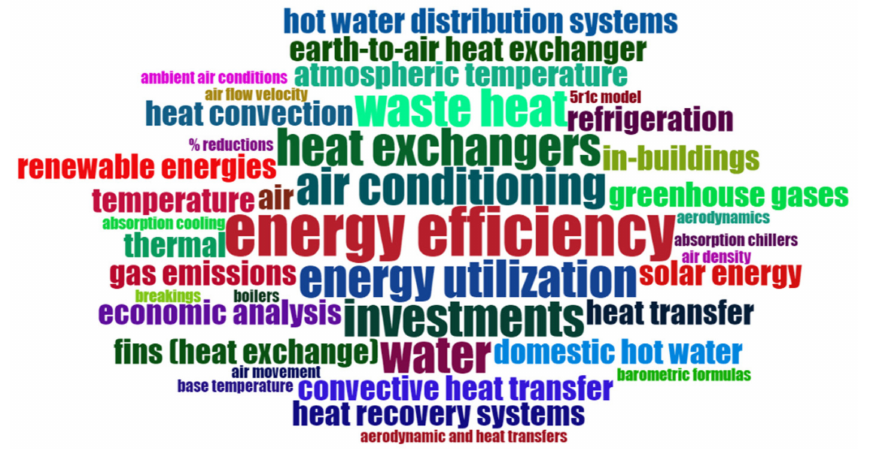
Figure 1. A word-cloud created from the articles published in the Special Issue. Zhao et al. aimed to optimize the flow and heat transfer performance of channels with frustums of a cone by using Response Surface Methodology (RSM) and multi-objective genetic algorithm [2]. Central composite face-centered design (CCF) was used for the experimental design of channel parameters, and response surface models were